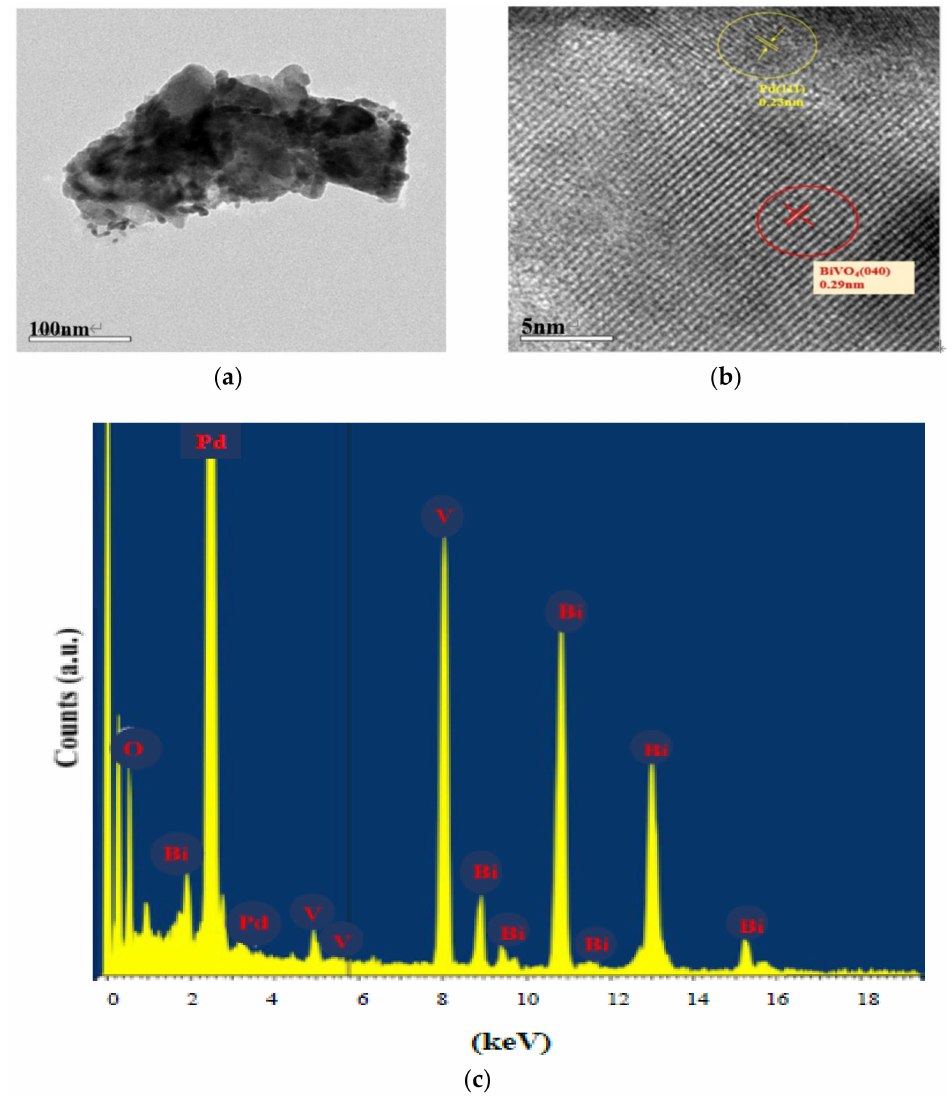
Figure 4. ( a ) TEM images of 1%Pd/BiVO 4 ; ( b ) TEM images of 1%Pd/BiVO 4 with high magnification, and ( c ) EDS spectrum of 1%Pd/BiVO 4